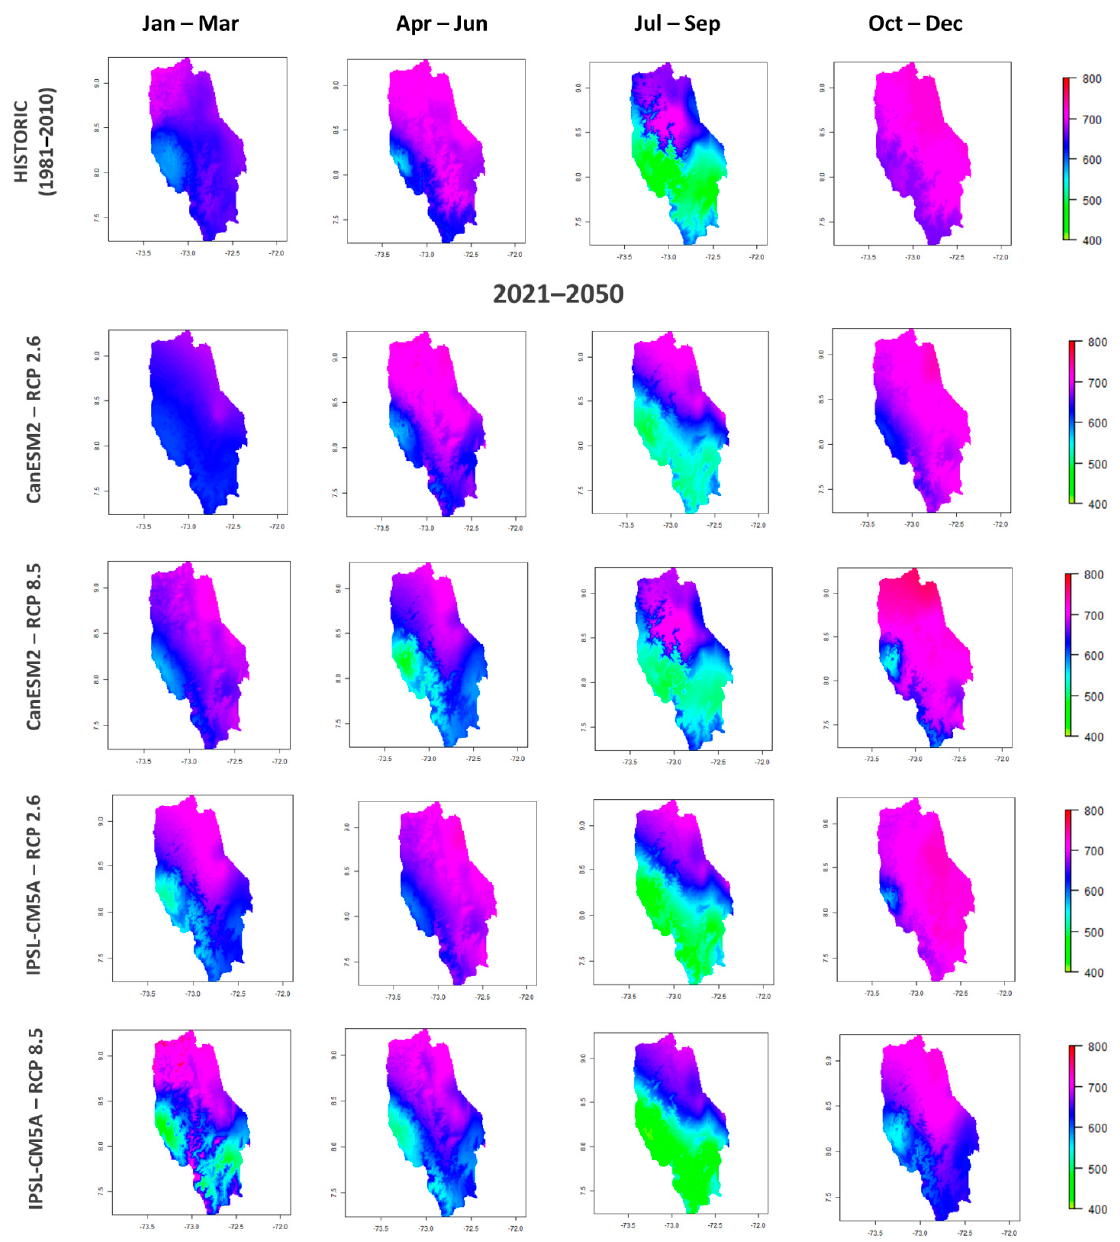
Figure A7. Soil Moisture Figure B3. Soil Moisture 2021–2050